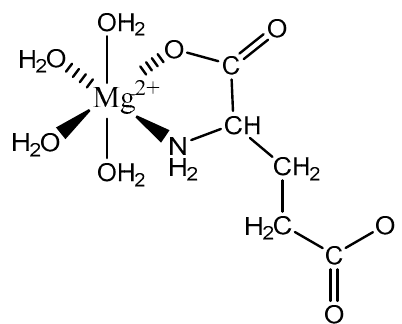
l -Glu) · 4H 2 O reported by Schmidbaur et al. [65,111].